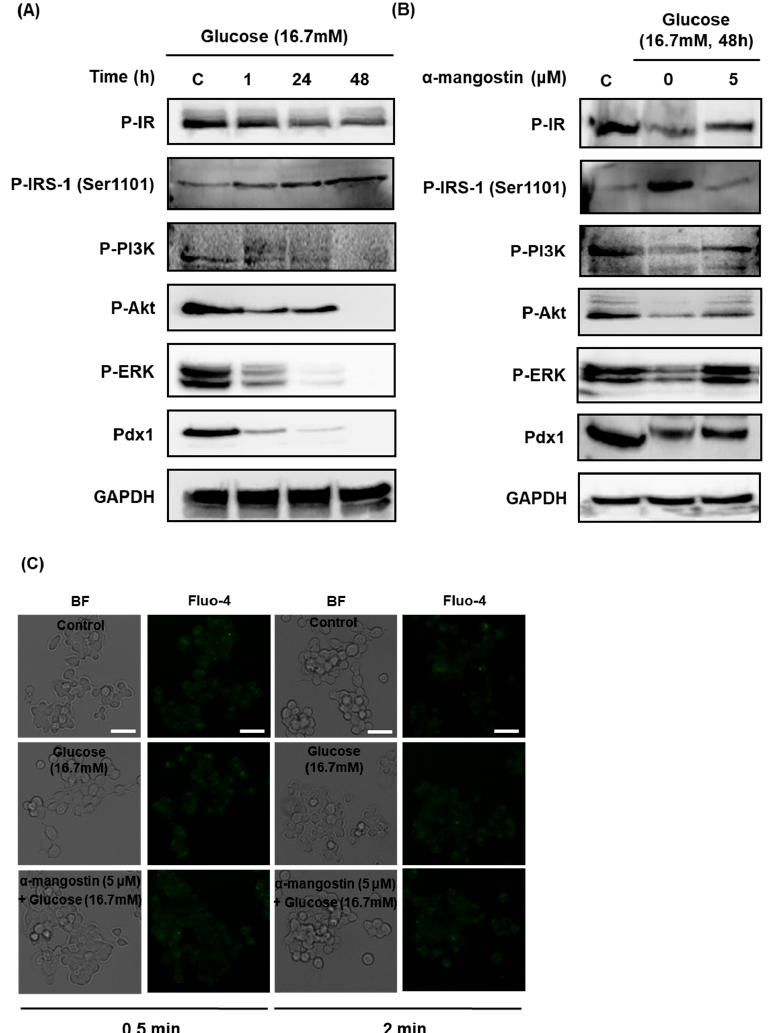
Figure 3. Effect of α -mangostin on the protein expression levels of P-IR, P-IRS-1 (Ser1101), P-PI3K, P-Akt, P-ERK, Pdx1 and intracellular Ca 2+ in INS-1 cells with hyperglycemia-induced insulin resistance. ( A ) Protein expression levels of P-Insulin receptor, P-IRS-1 (Ser1101), P-PI3K, P-Akt, P-ERK, Pdx1, and GAPDH in INS-1 cells treated with 16.7 mM glucose (high glucose concentration) for different times. ( B ) Protein expression levels of P-Insulin receptor, P-IRS-1 (Ser1101), P-PI3K, P-Akt, P-ERK, Pdx1, and GAPDH in INS-1 cells treated or untreated with 16.7 mM glucose (high glucose concentration) and 5 μ M α -mangostin for 1 h. ( C ) Intracellular Ca 2+ in INS-1 cells treated with 16.7 mM glucose (high glucose concentration) and 5 μ M α -mangostin for different times. Scale bar = 50 μ m.